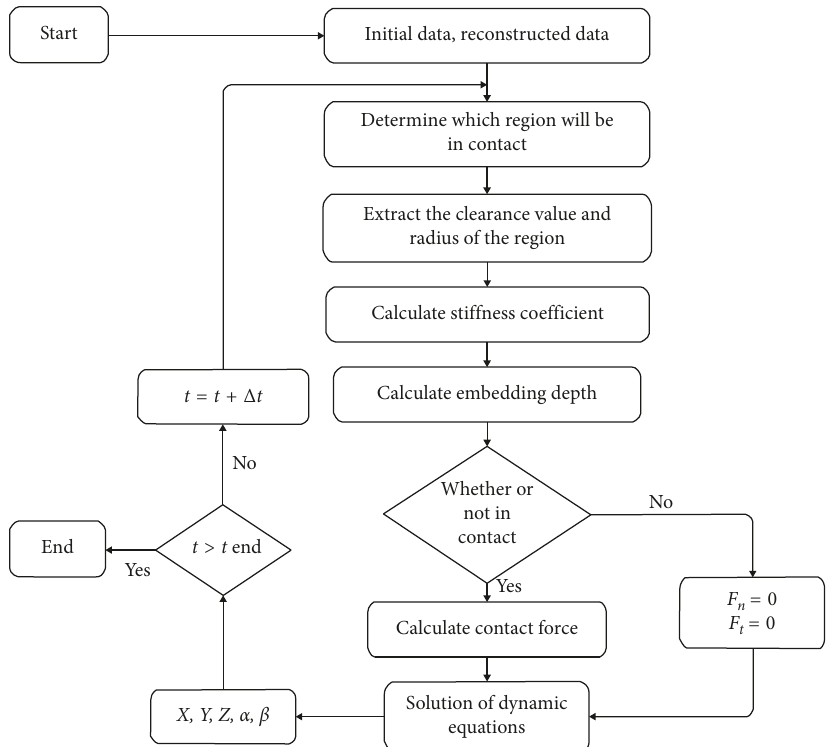
Figure 8: Dynamic solution process after